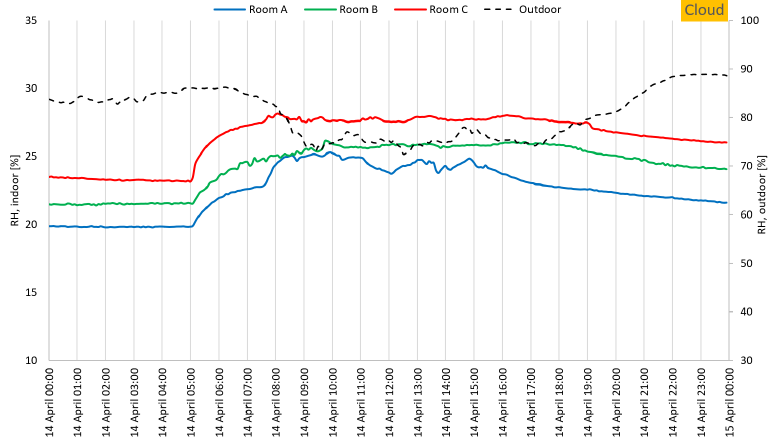
Figure 20. Comparison of temperature outdoors and indoors in all three rooms for 1 day when it was cloudy outside. The indoor temperature of the three rooms is shown on the left axis, and the outdoor temperature is shown on the right axis.